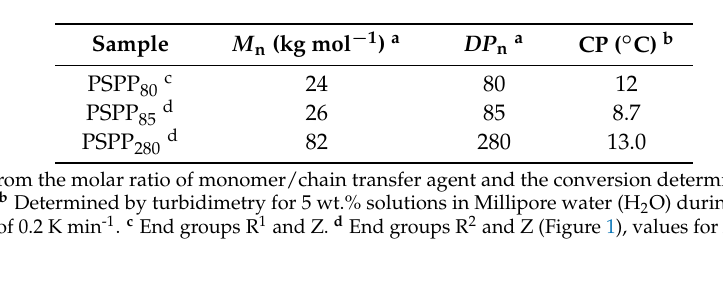
Table 2. Sample characteristics of polyzwitterions PSPP n studied: number-average molar mass M n , degree of polymerization DP n and cloud point